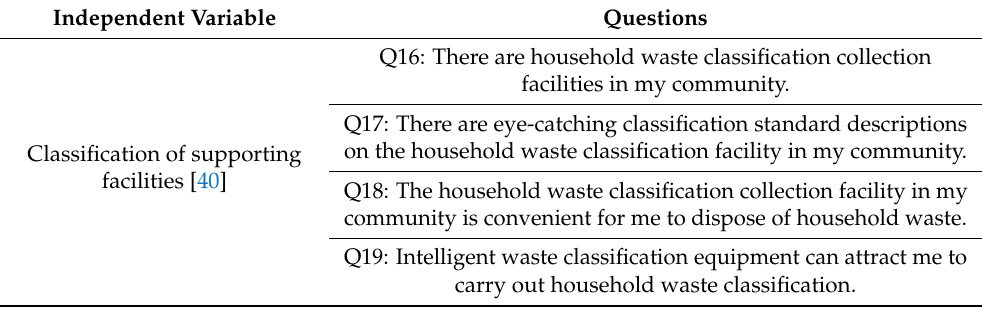
Table 4. Classification and supporting facilities questions.